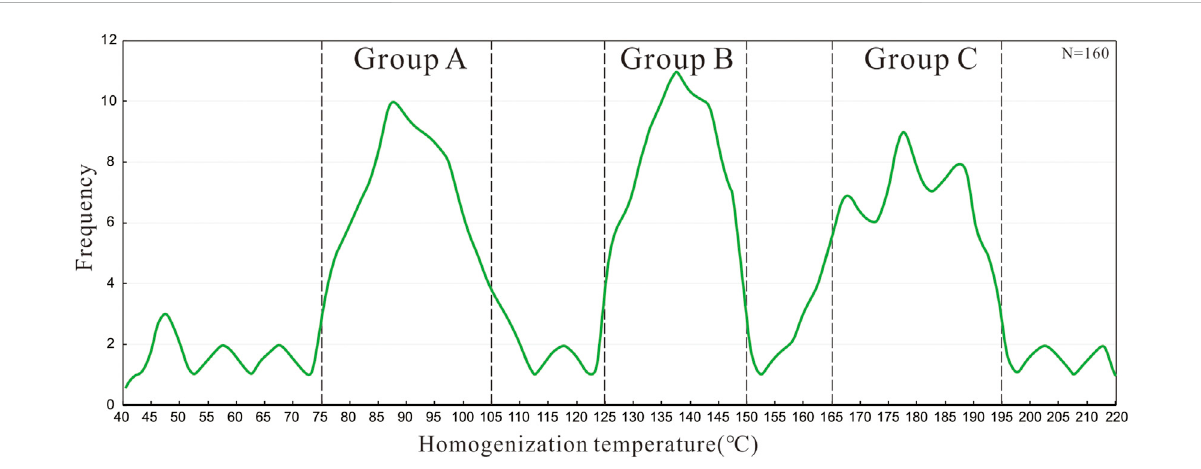
FIGURE 1 Frequency histogram of the homogenization temperature (Th) for tectonic fracture calcite cements of the Lucaogou Formation in the Jimsar Sag, Junggar Basin.